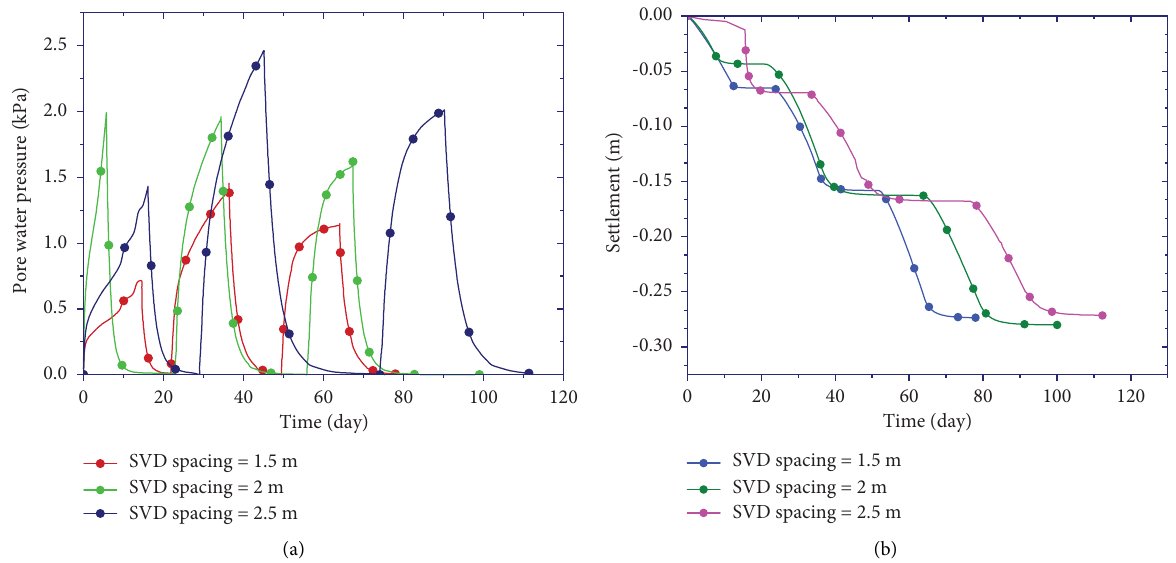
Figure 10: (a) Te efect of SVD spacing on pore water pressure (for D � 0.6m and L � 15m). (b) Te efect of SVD spacing on settlement (for D � 0.6 m and L � 15m).